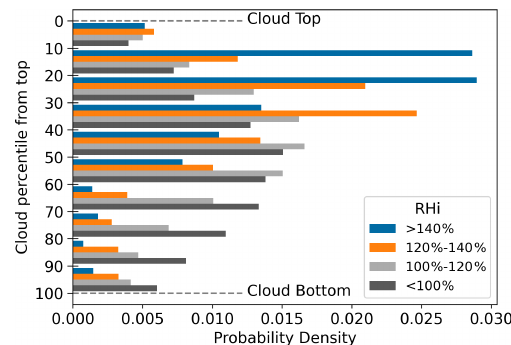
Figure 3. Probability densities of RHi in a relative location to the cloud top. RHi values of in-cloud data points are grouped into four, approximately representing the subsaturation (dark grey), low HET regime (grey), high HET regime (orange) and HOM regime (blue). For every group the probability density in bins with respect to the relative location to the cloud top is plotted. For example: the bin from the 20th to the 30th percentile contains the probability of oc- currence of the four RHi groups in a slice of the cloud located 20% to 30% of the distance between the cloud top and cloud